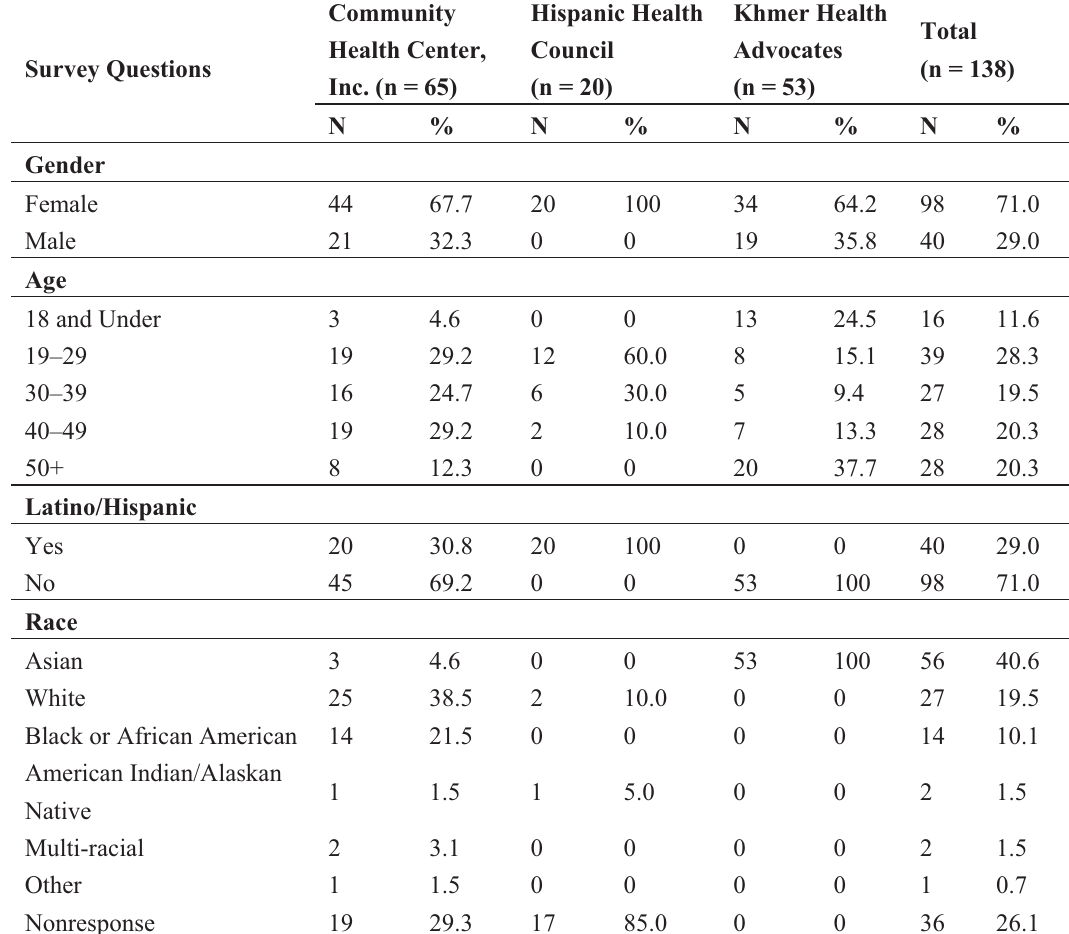
Table 3. Demographic statistics of FHH participants (n =